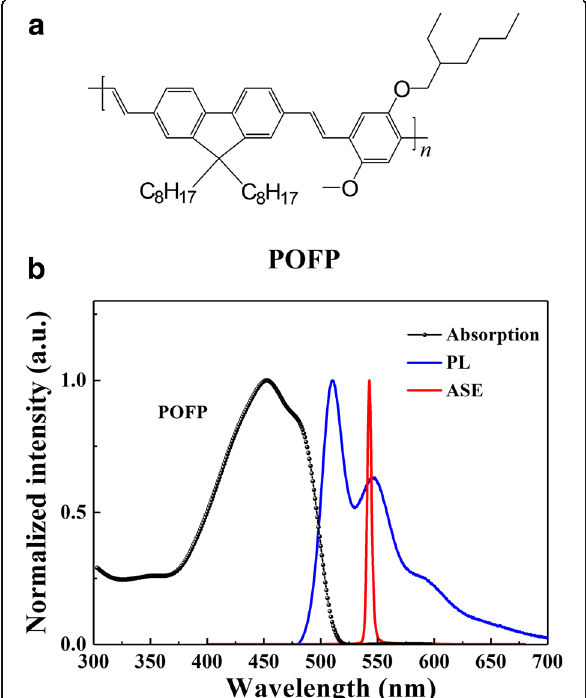
Fig. 1 a The molecular structure of POFP. b The absorption, PL, and ASE spectra of POFP thin